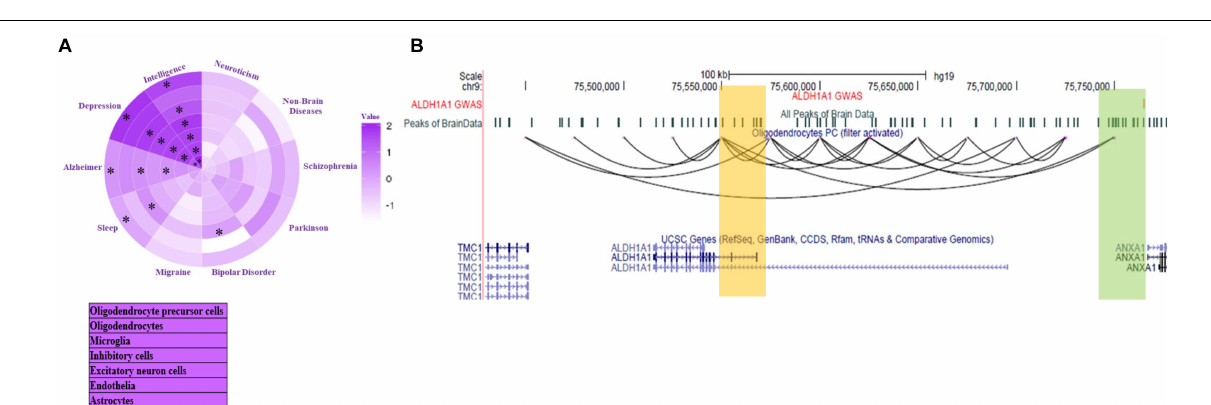
FIGURE 3 | Inference about the cell-type of action and associated known target genes for expression QTL (eQTL) in the human brain. (A) The number of brain eQTL with target genes lying more than 500 kbp and over-lapping with predicted chromatin interaction in seven brain cell types. (B) UCSC browser snapshot showing a Brain eQTL and its target gene SOX10 connected with predicted long-range chromatin interaction in oligodendrocyte precursor (OPC).